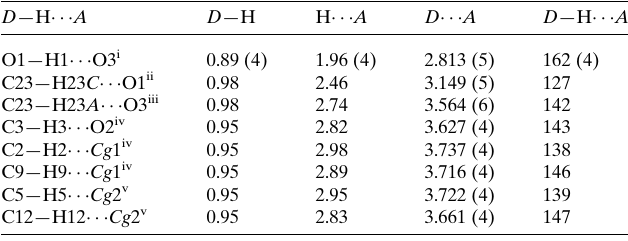
Table 1 Hydrogen-bond geometry (A˚ , (cid:3) ).